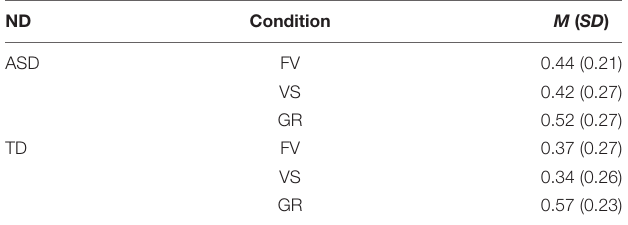
TABLE 3 | Mean proportion and standard deviations of FF% by group and condition (ND, neurodevelopment; ASD, autism spectrum disorder; TD, typical development; FV, free-viewing; VS, visual search; GR, gaze-reading; N, number; M, mean; SD, standard deviation).